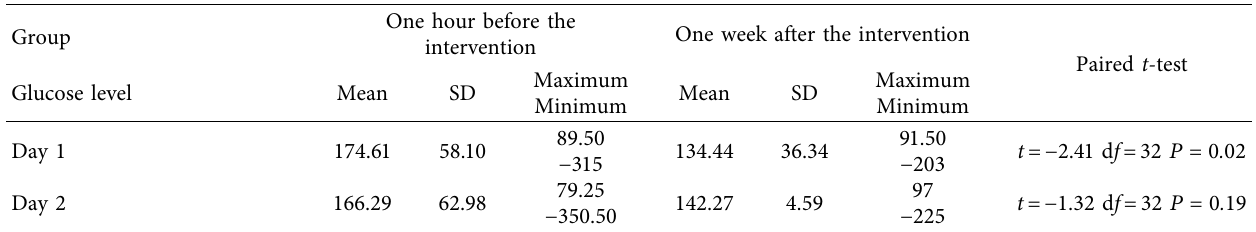
Table 3: Comparison of the glucose level in the intervention and control groups every 6hours, and in the bolus and continuous feeding groups during one week of intervention, 2018.